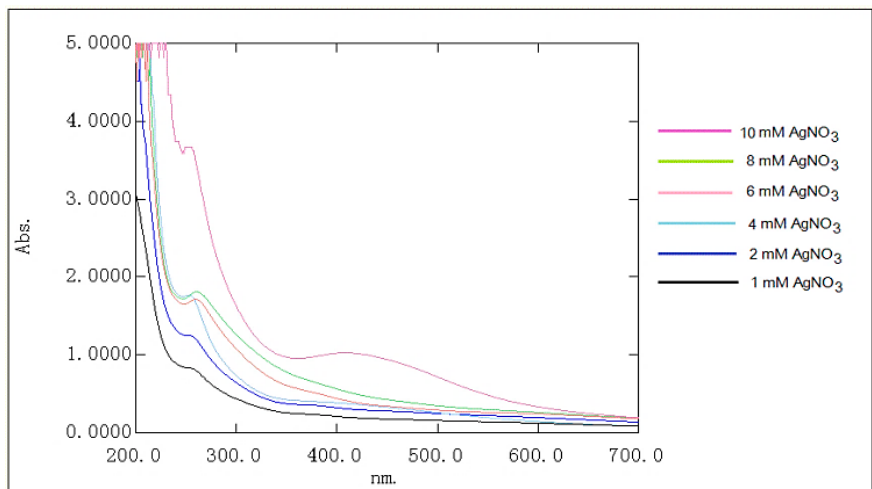
Figure 1. UV-vis spectra of AgCl-NPs in different concentration of AgNO 3 .